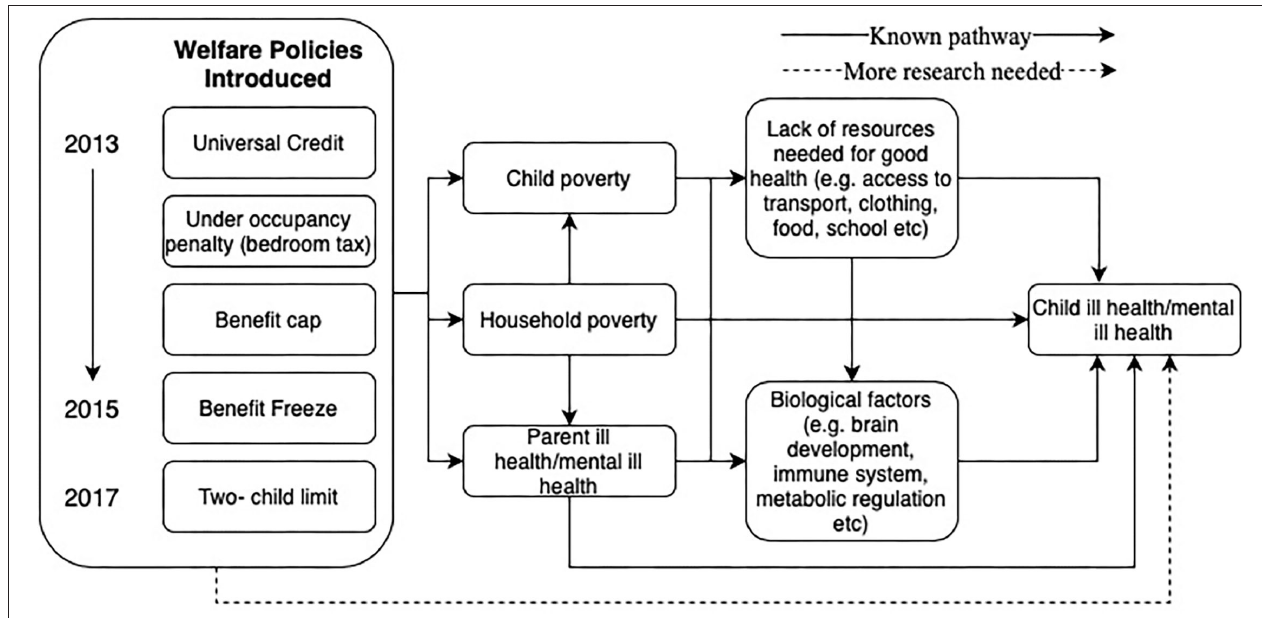
FIGURE 1 | Potential pathways and mechanisms from specific welfare policy changes to poor parent and child health mental